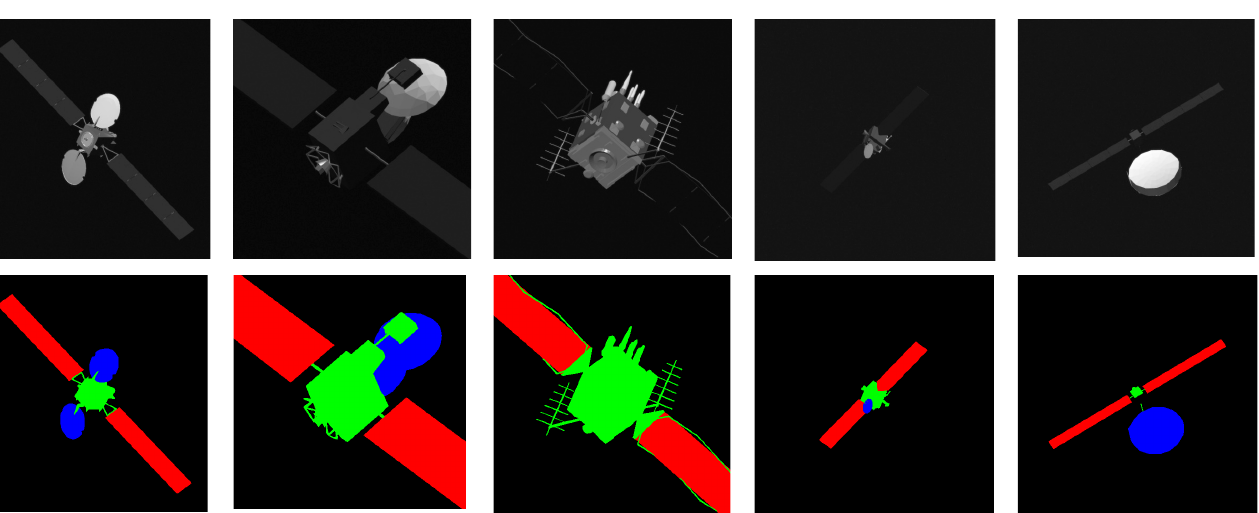
( b ) Figure 3. Simulation in the STK: ( a ) Earth synchronous orbit (GEO); ( b ) camera’s field of view.